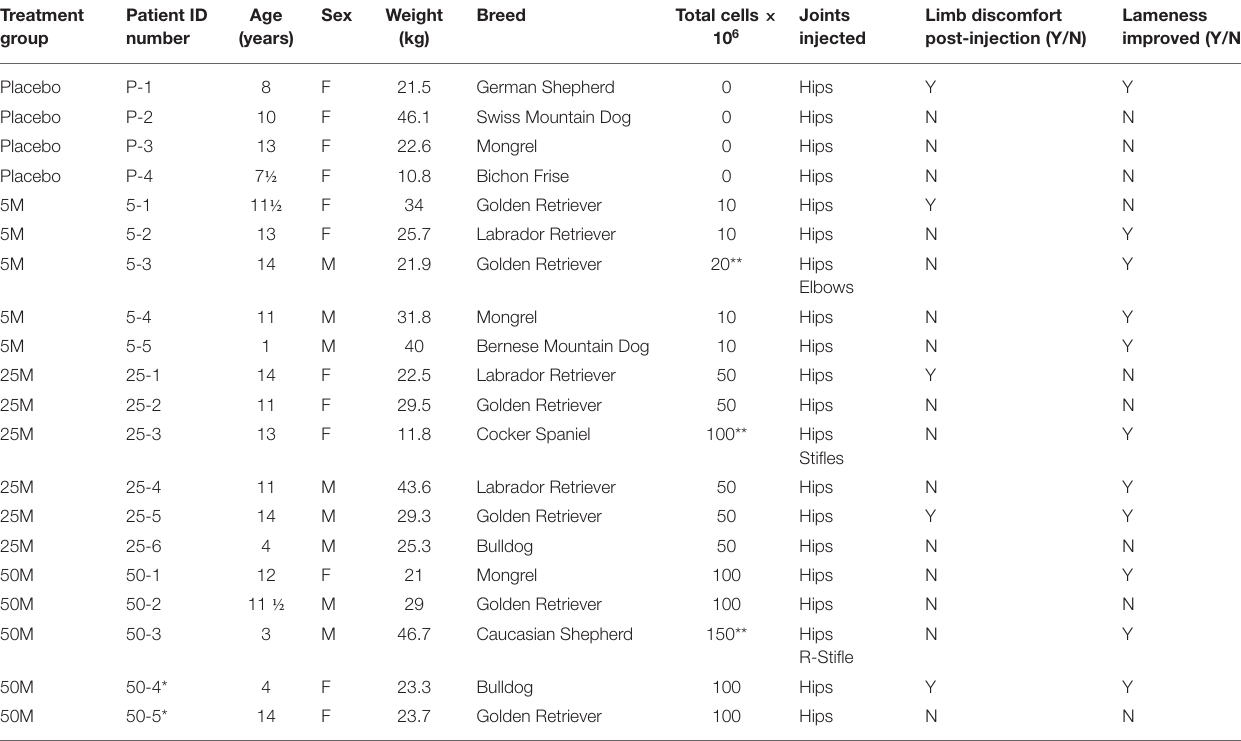
TABLE 1 | Distribution of patients enrolled in this study among different treatment groups. Treatment